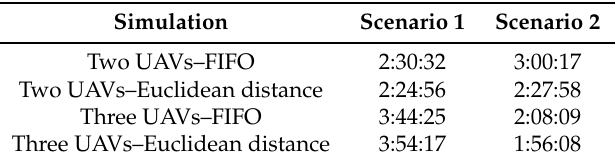
Table 4. Exploration time.